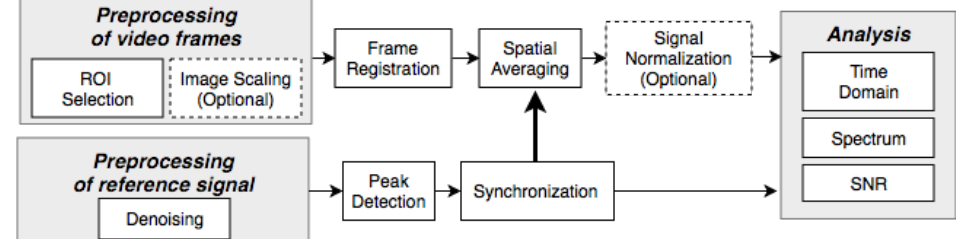
Figure 5. Signal processing framework used in this study. The contact reference signal was denoised by a 7 Hz low-pass filter.